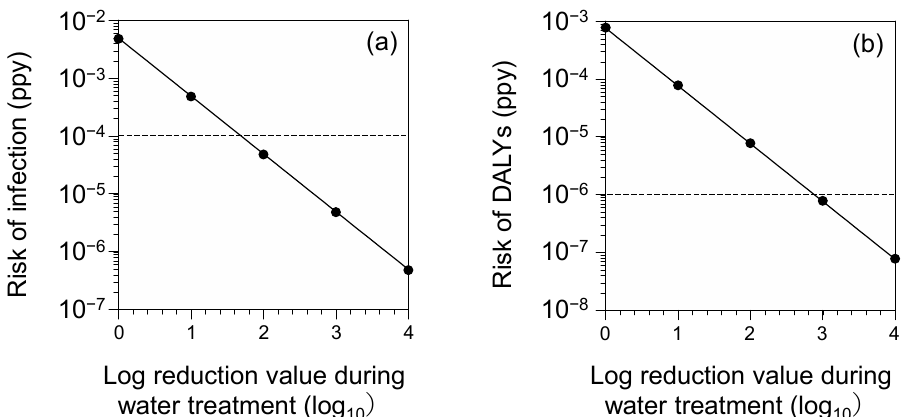
Figure 2. Risk of infection ( a ) and disability-adjusted life years (DALYs) ( b ) 95%tile values are shown. Dotted lines indicate benchmarks.